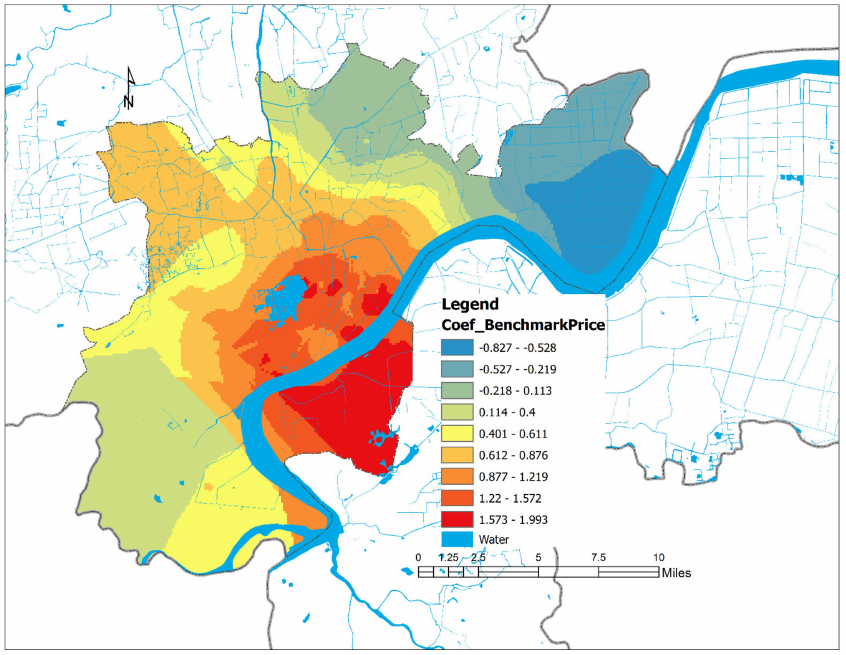
Figure 8. Residential land price level regression coefficient diagram of commercial land category